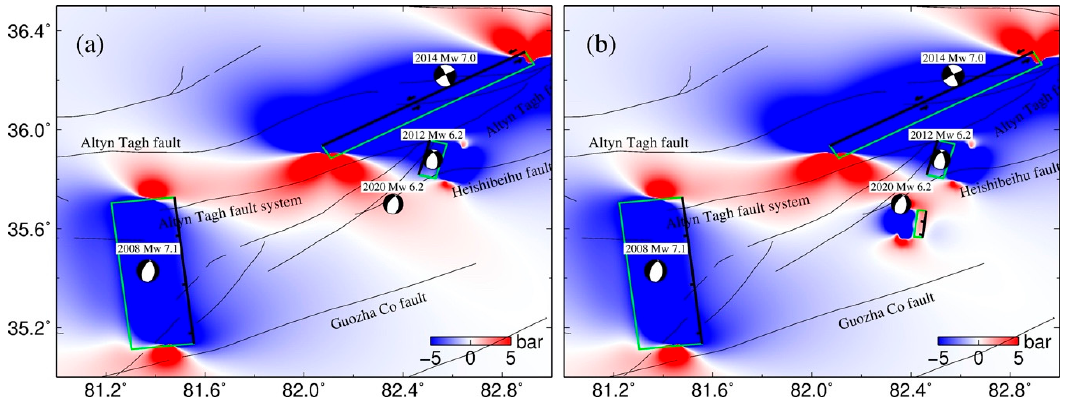
Figure 12. Coulomb failure stress changes in the Yutian region at depth of 10 km. Static Coulomb stress changes caused by ( a ) the Mw 7.1, the Mw 6.2, and the Mw 7.0 earthquakes in 2008, 2012, and 2014, respectively; and ( b ) the Mw 7.1, the Mw 6.2, the Mw 7.0, and the Mw 6.2 earthquakes in 2008, 2012, 2014, and 2020, respectively. The receiver fault adopted the same fault parameters as the mainshock of 2020, with strike of 186.4°, dip of 64.8°, and rake of –99.5°; the friction coefficient is 0.4. Rectangular frames represent locations of fault planes for the four events.